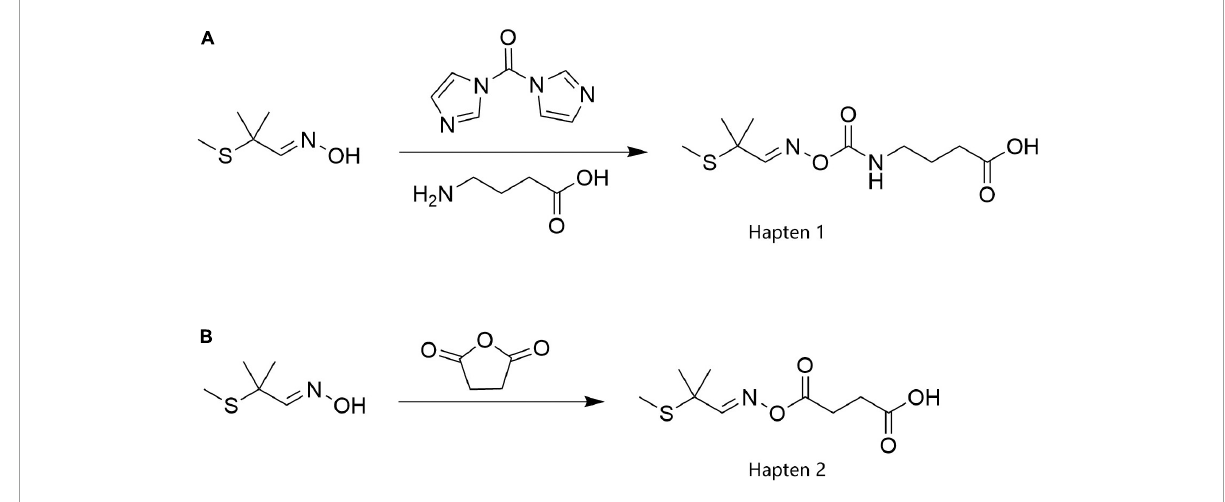
FIGURE1 The synthesis routes of aldicarb